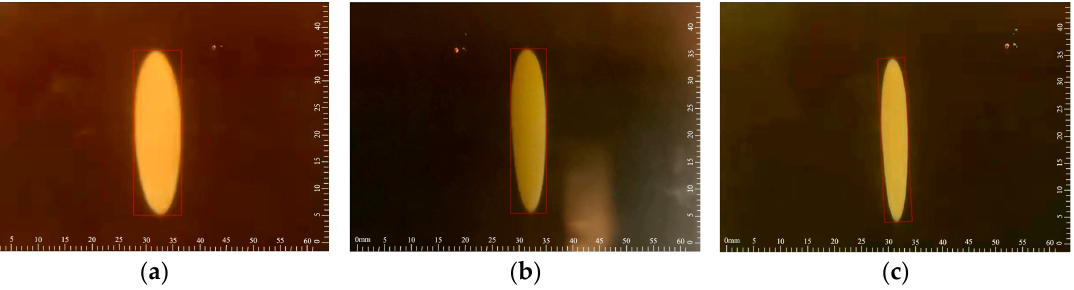
Figure 8. BFRs of phantom after ultrasonication with different combinations of acoustic power and time: ( a ) 25 W × 449 s, ( b ) 50 W × 58 s, ( c ) 75 W × 19 s. It could be seen from Figure 9 that in the phantom experiment, HIFU needed 448 s to induce a BFR with a length of 31.58 mm with an acoustic power of 25 W, and this BFR’s width was 9.17 mm, and the axis length ratio was 3.45, which was far from the axis length ratio of the AFR. The axis length ratio was 5.97 with an acoustic power of 75 W, and the shape of the BFR was closer to that of the AFR, and the exposure energy required was reduced by 87.38%.